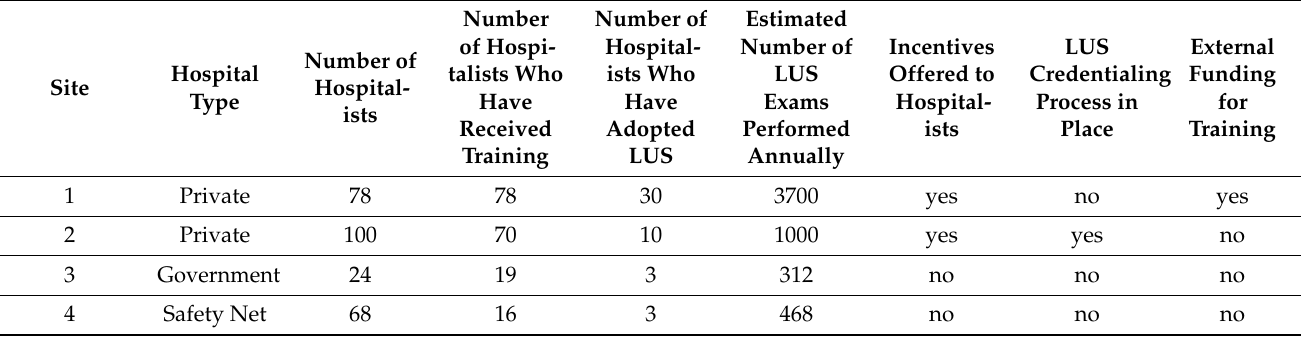
Table 3. Description of Study